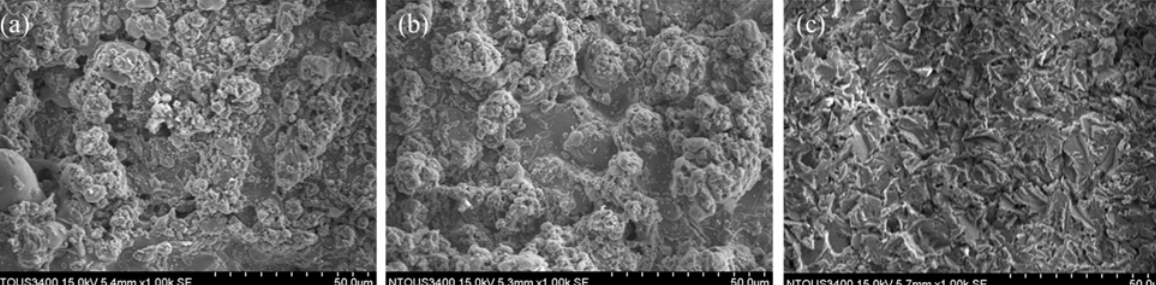
Figure 2. Measured results of the sprayed coating: ( a ) XRD spectrum, ( b ) DSC curves. Table 2. Related temperature parameters calculated from DSC curves.